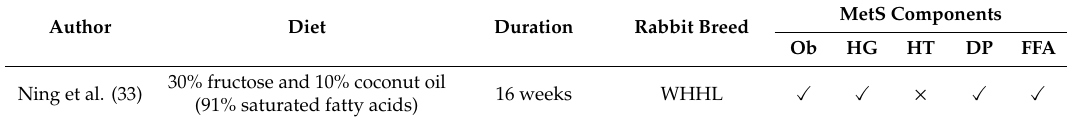
Table 4. E ff ects of fructose and fat-enriched diets on the development of